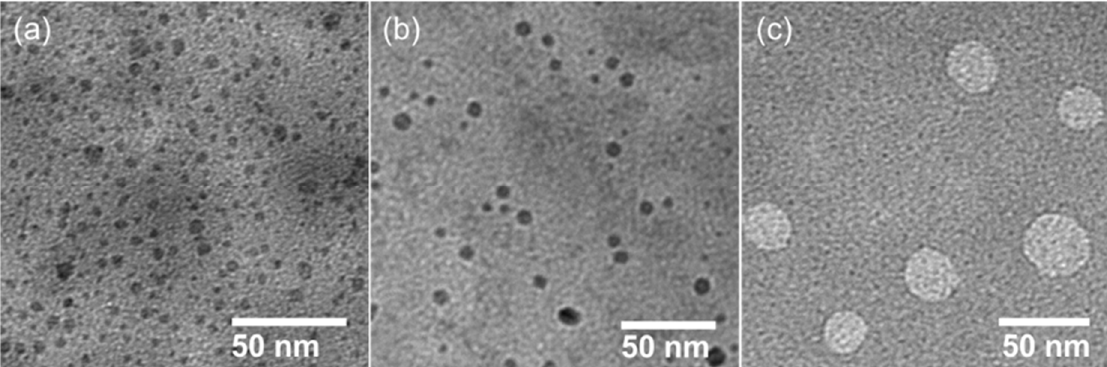
Figure 2. Representative TEM images of nanoparticles formed by the self-assembly of HPG-4 ( a ), HPG-6 ( b ), and HPG-7 ( c ).